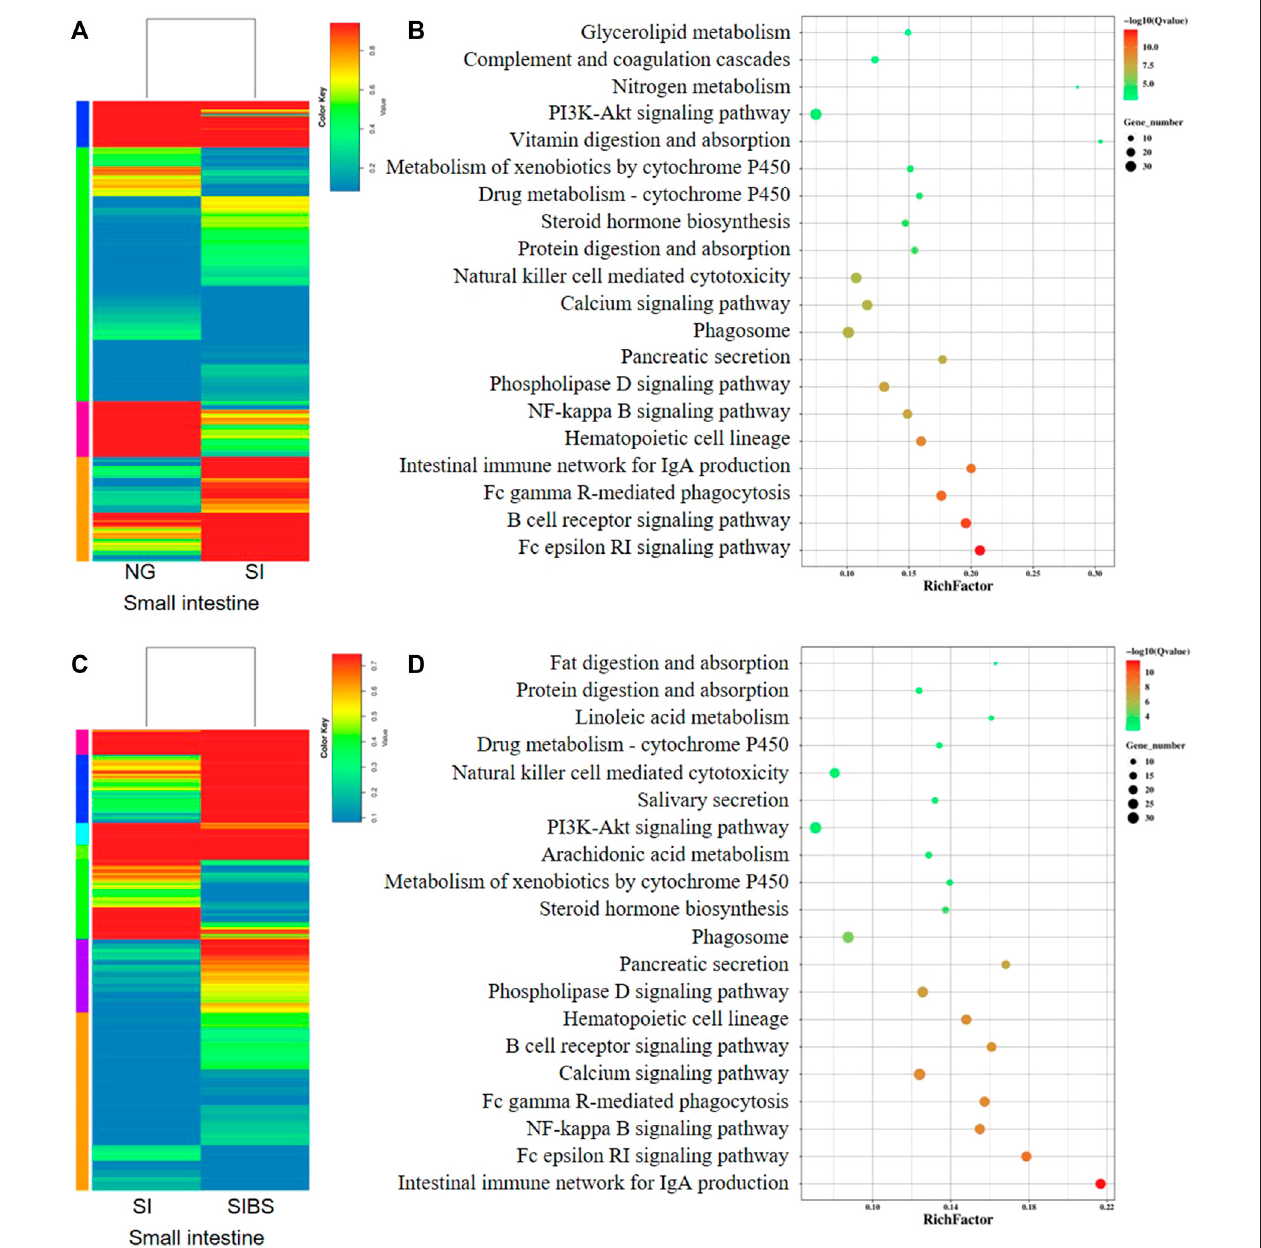
FIGURE 5 | Comparison of DEGs in the small intestinal tissues were analyzed by KEGG enrichment and volcano diagram analysis. (A,B) Comparison of DGEs between the NG and SI groups. (C,D) Comparison of DGEs between the NG and SI groups. NG: normal mice with PBS group. SI: S. japonicum – infected mice group. SIBS: S. japonicum – infected mice with OA B. subtilis group. The size of each circle represents the number of genes.